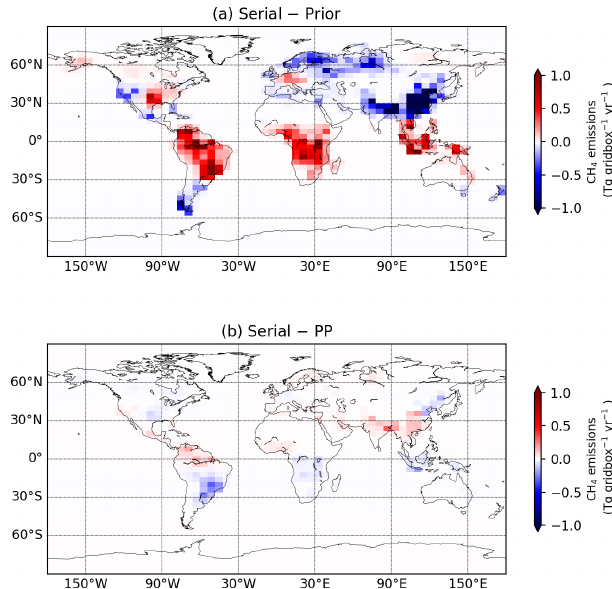
Figure 8. Emission differences averaged over 1999–2010. Panel (a) shows differences between serial and prior. Panel (b) shows dif- ferences between serial and